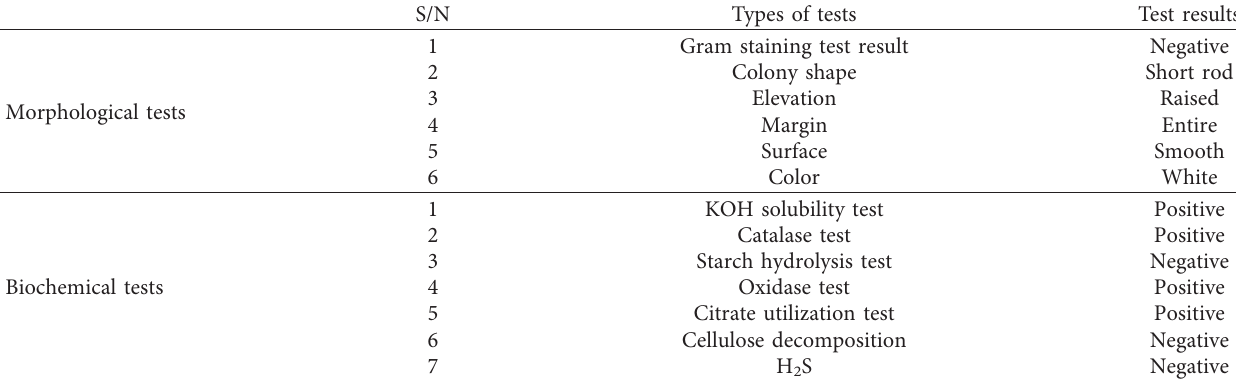
Table 3: Average percent severity index and percent disease incidence of pepper wilt disease. Disease condition PSI, percent severity index; PDI, percent disease incidence.